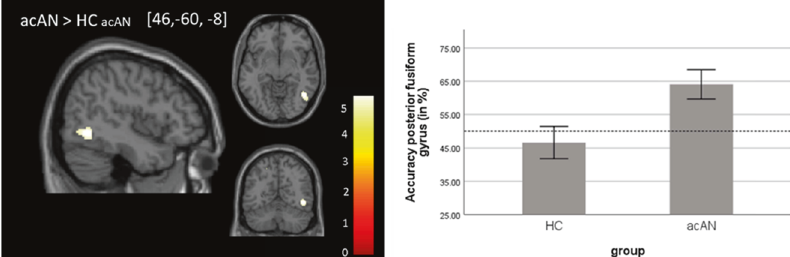
Fig. 1 Group difference in classi fi cation accuracy between acAN and HC acAN in the food vs. neutral contrast ( p < 0.05, FWE); left panel: whole-brain map of the group difference; right panel: extracted classi fi cation accuracy values of the fusiform gyrus plotted for healthy control (HC) and acutely ill patients (acAN). Left panel: peak coordinate in brackets; right panel: dashed line marks the chance level; error bars represent 95% con fi dence